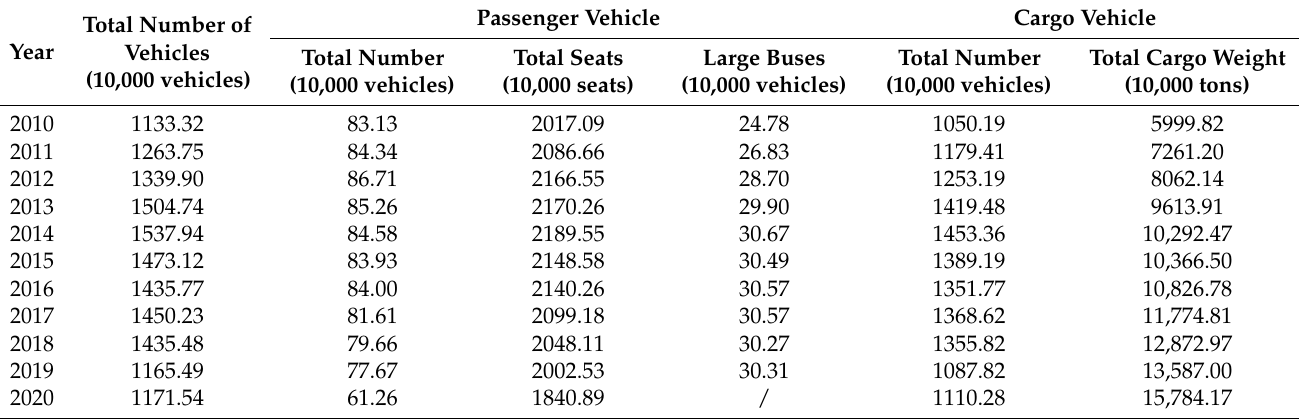
Table 2. Statistics of China’s road traffic